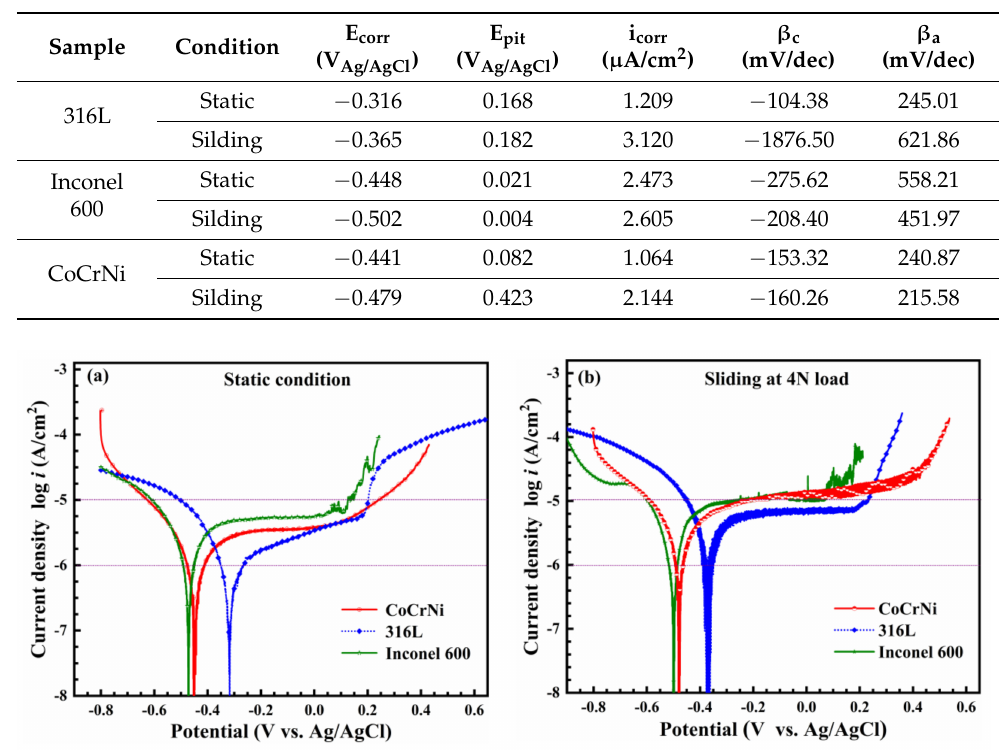
Table 1. Triboelectrochemical parameters of three alloys under both static and tribocorroison state in 3.5 wt.%NaCl solution.E corr : self-corrosion potential; E pit : pitting potential; i corr : corrosion current density; β c and β a : cathodic and anodic slopes.